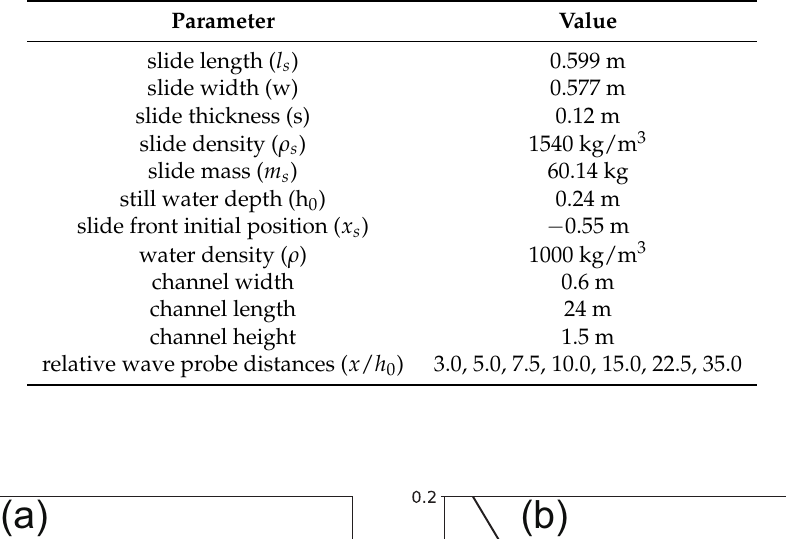
Table 2. Summary of important parameters in the Heller et al. [5] experiment (Figure 1b).